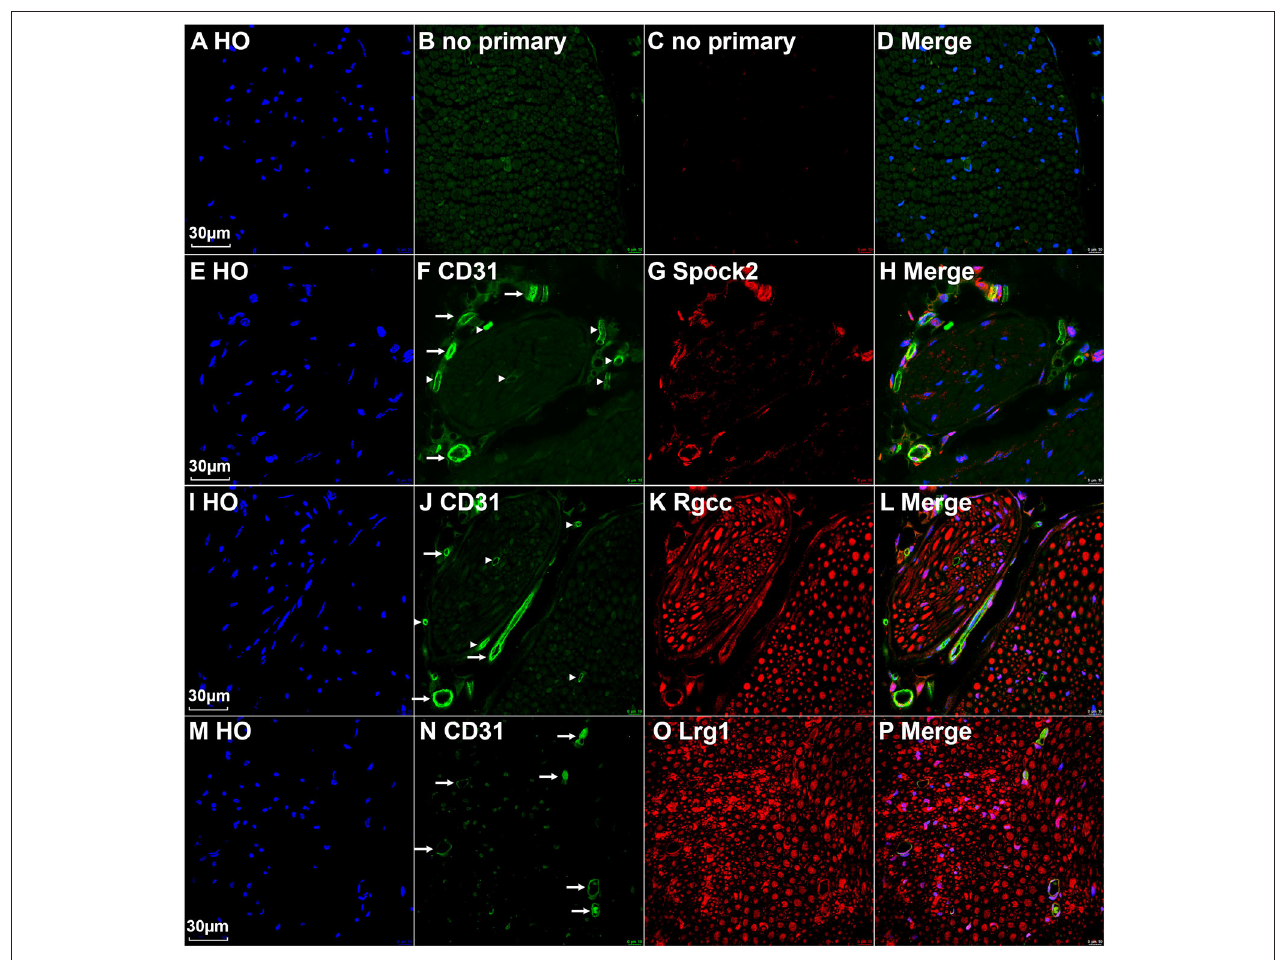
FIGURE 5 | Identify epineurial and endoneurial endothelial cells in intact mouse sciatic nerve by immunostaining. (A–D) Control slides staining without adding primary antibodies in the blocking buffer. (E–H) Double staining CD31 with Spock2 showing that Spock2 is strongly expressed in ECs of large diameter blood vessels outside the epineurium (indicated by arrows). Arrowheads show no expression. (I–L) Double staining CD31 with Rgcc showing that Rgcc is strongly expressed in ECs of large diameter blood vessels outside the epineurium (indicated by arrows). Arrowheads show no expression. Rgcc is also strongly expressed in axons inside the endoneurium. (M–P) Double staining CD31 with Lrg1 showing that Lrg1 is expressed in ECs of endoneurium (indicated by arrows). Lrg1 is also strongly expressed in axons inside the endoneurium. Scale bars in (A) , (E) , (I) , and (M) 30 µ